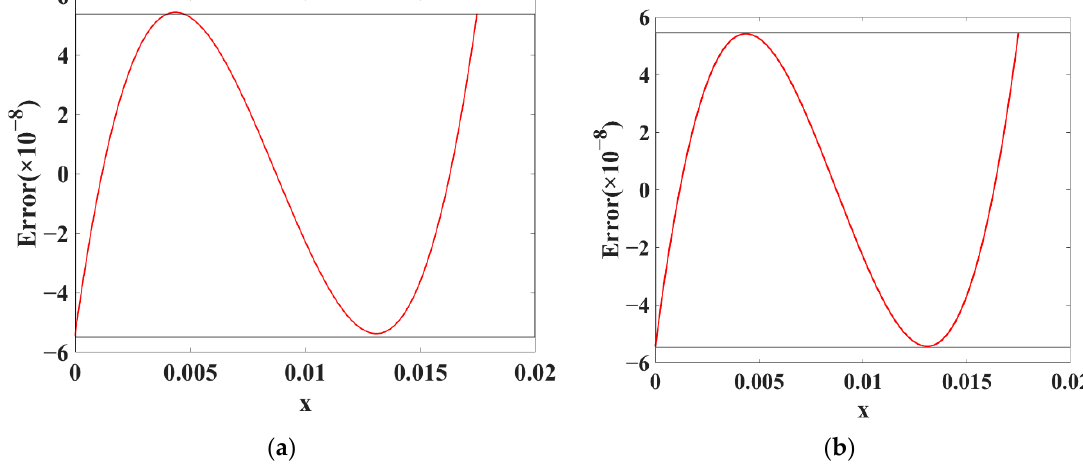
Figure 1. Error distribution of the first segment for function ln(1 + x). ( a ) ln(1 + x), c2 = 0.500; ( b ) ln(1 + x), c2 = 0.498. Table 1. The δ for common functions.